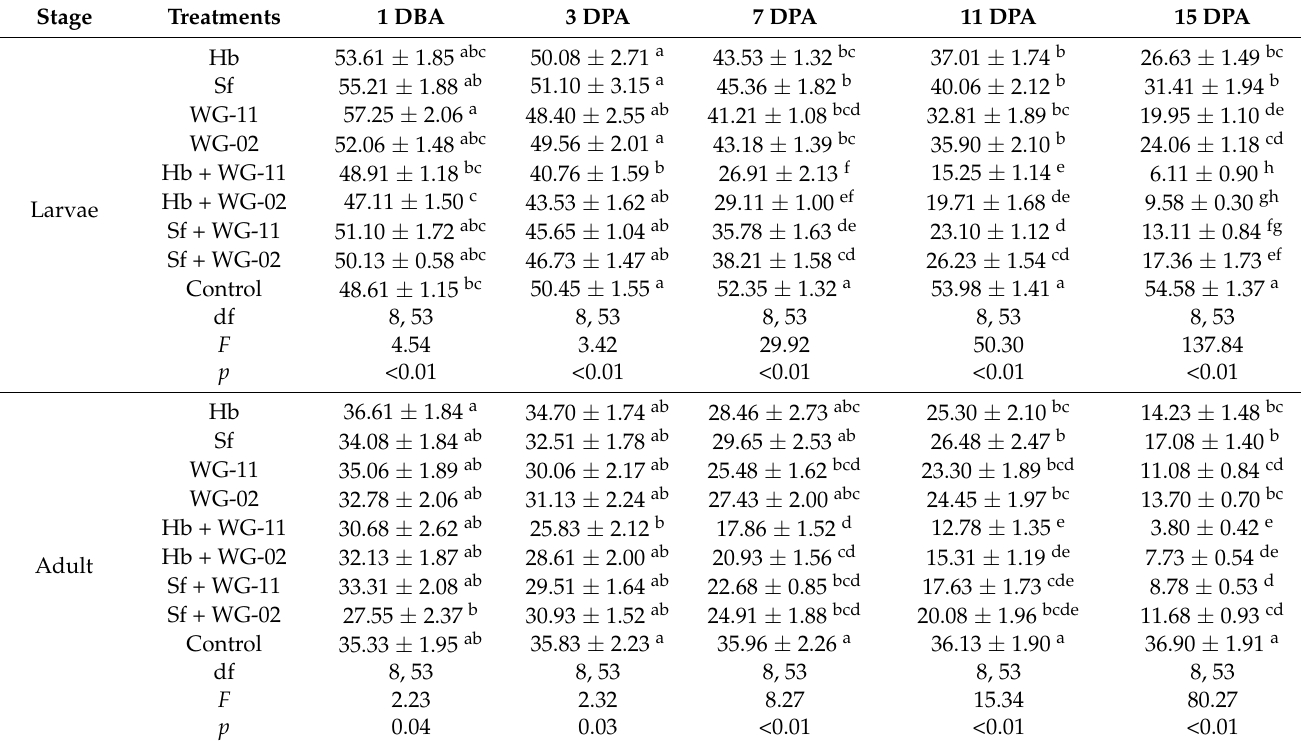
Table 5. Mean ( ± SE) adult and larvae of Thrips tabaci at 1 day before application (DBA), and 1, 3, 7, 11, and 15 days post-application (DPA) treatment when treated with Hb = Heterorhabditis bacteriophora , Sf = Steinernema feltiae , WG-11 = Beauveria bassiana (WG-11), WG-22 = Metarhizium anisopliae (WG-02), Hb + WG-11 = H. bacteriophora + B. bassiana , Hb + WG-02 = H. bacteriophora + M. anisopliae , Sf + WG-11 = S. feltiae + B. bassiana , Sf + WG-02 = S. feltiae + M. anisopliae, control = water only under field conditions during 2018–2019. Different letters in each column indicate statistical significance ( p < 0.05; Tukey’s